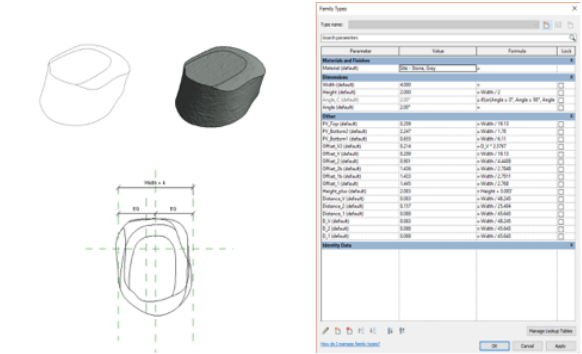
Figure 5: Three-dimensional parametric model of a rocky element. In the image there are: an axonometric textuizzata view, a fil rouge, the plant with one of the constraints and the table with all the priorities. The model is parameterized so as to be able to control the curvature of the edges of the element in addition to the